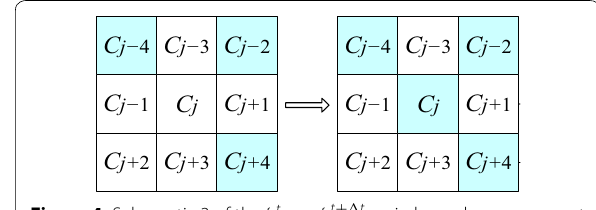
Figure 2 Schematic 1 of the ξ t Cj → ξ t + � t Cj grain boundary movement